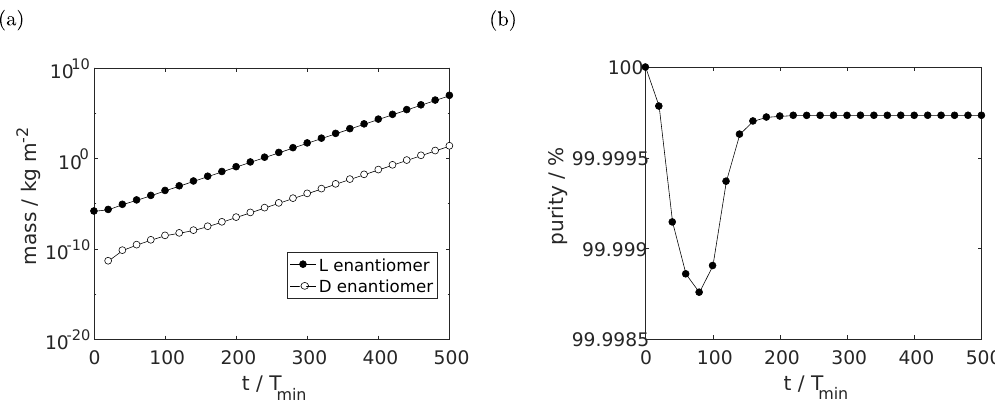
Figure 8. ( a ) Total mass of the crystal phase per unit cross-sectional area for the simulation in Figure 7; ( b ) purity of the crystal phase, defined as the mass of L crystals divided by the total crystal mass, for the same